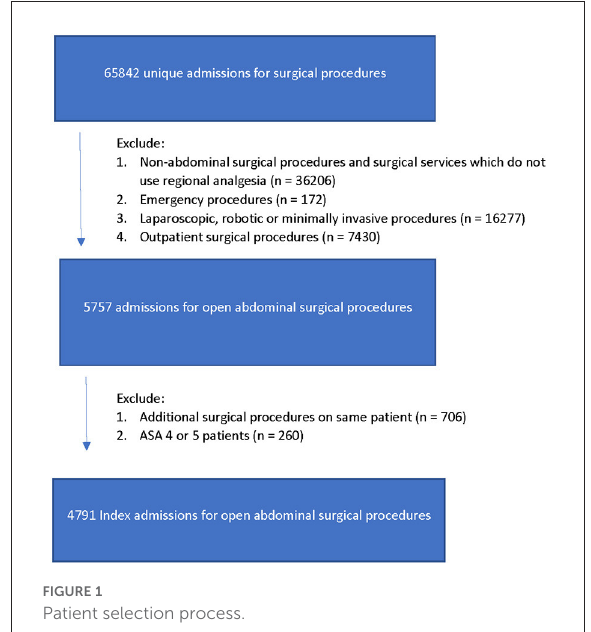
FIGURE1 Patient selection process.